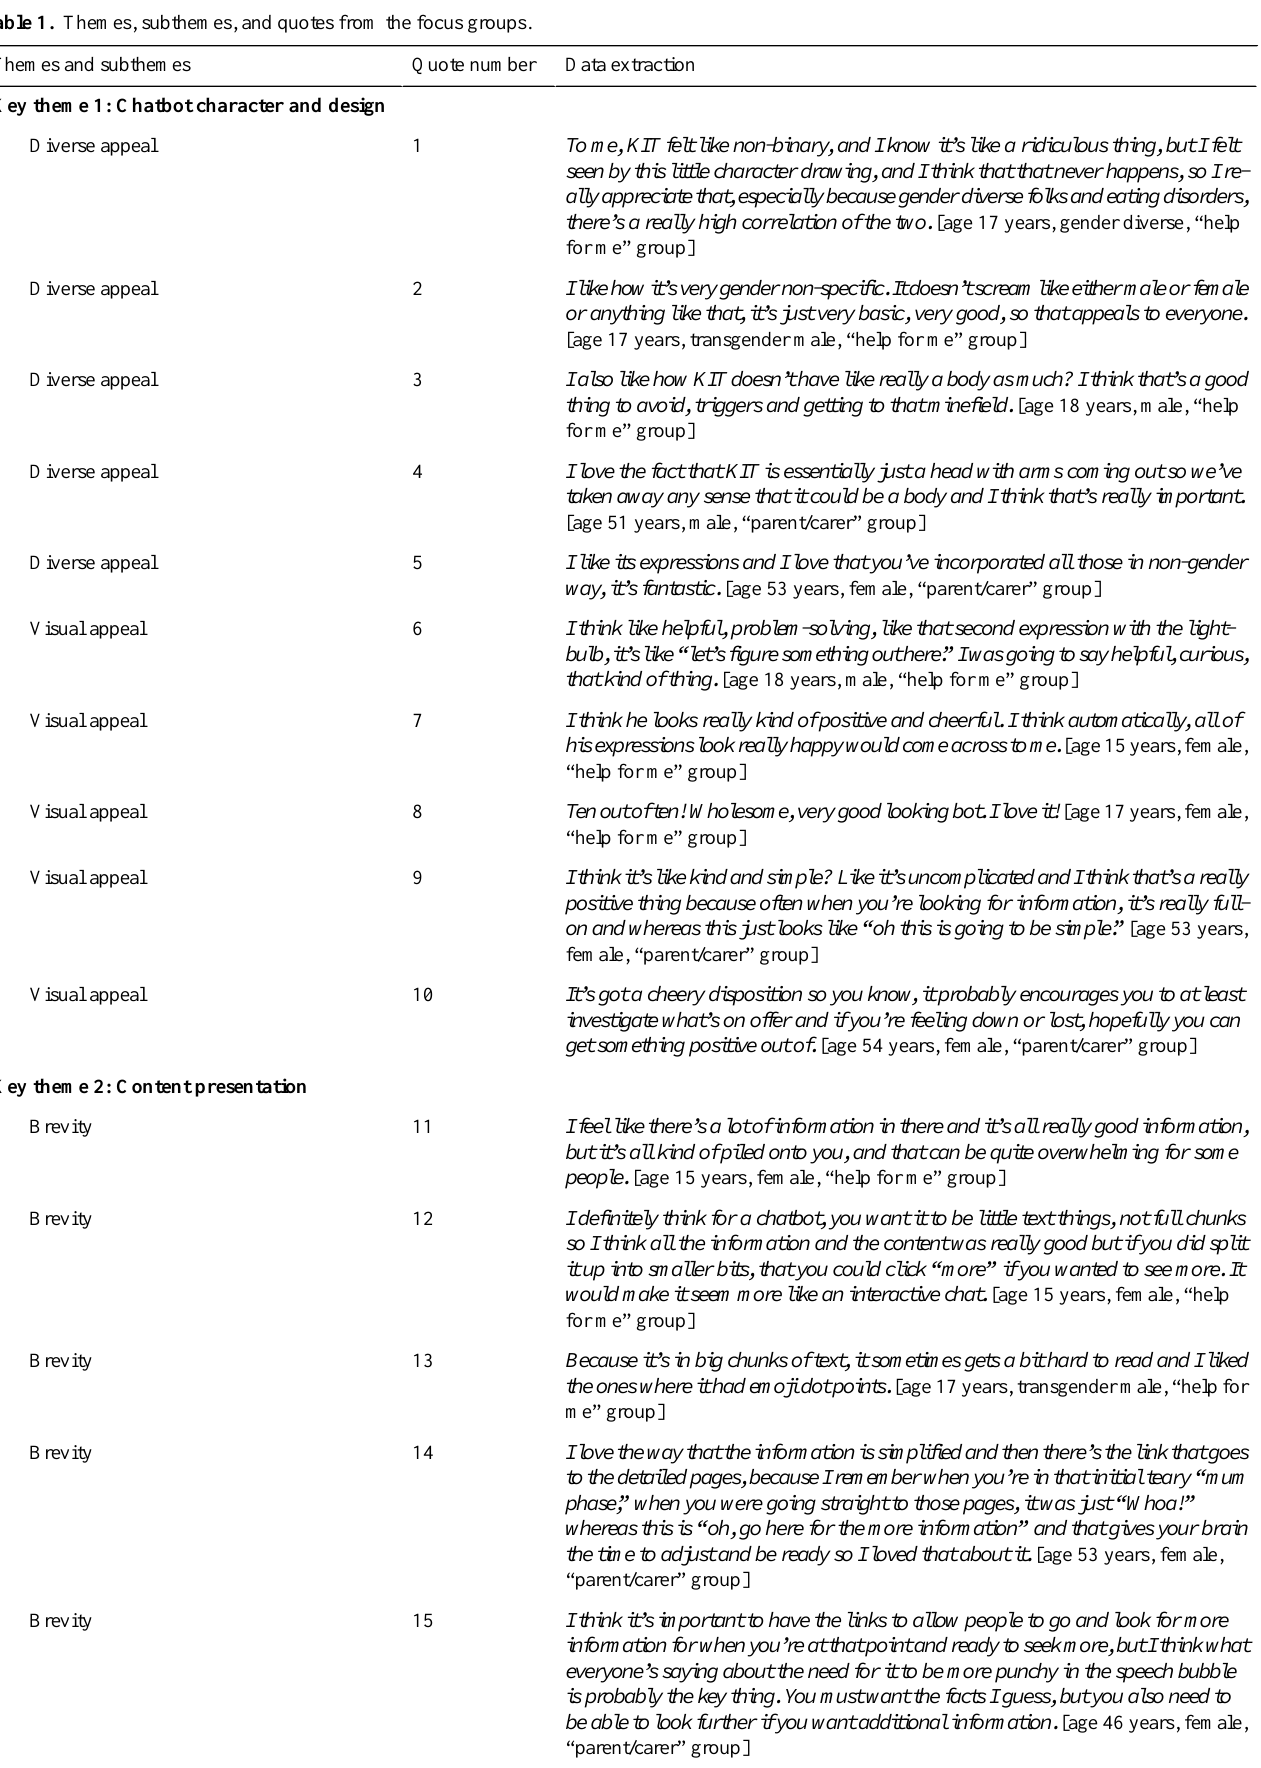
Data extractionQuote numberThemes and subthemes